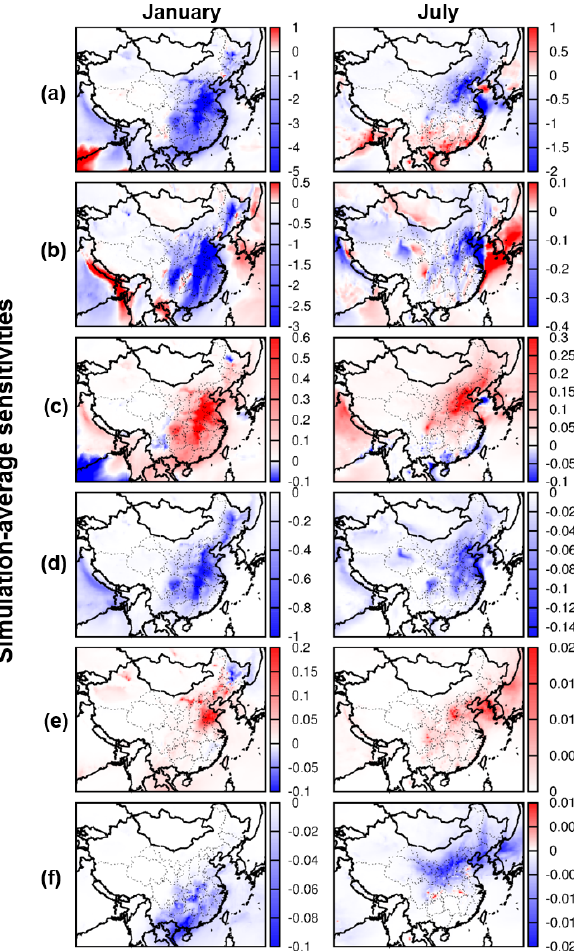
Figure 8. Sensitivity of the O 3 -8h mean to meteorological pertur- bations (a) T , (b) WS, (c) AH, (d) PBLH, (e) CLW, and (f) PCP in China. The value in T is measured in ppbK − 1 and others in ppb% − 1 .